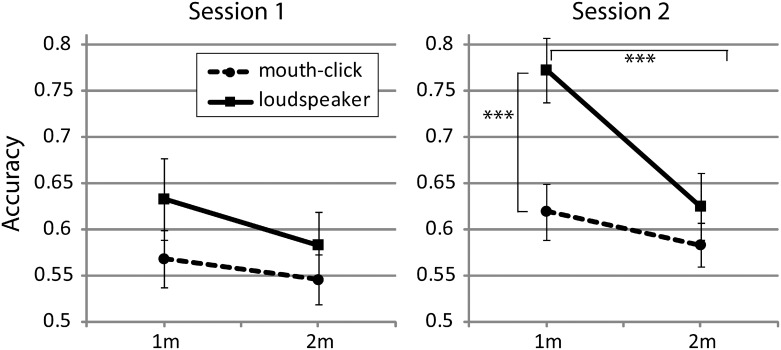
Performance split by session, distance and sound.Error bars represent SEM across participants. *** p<.001.